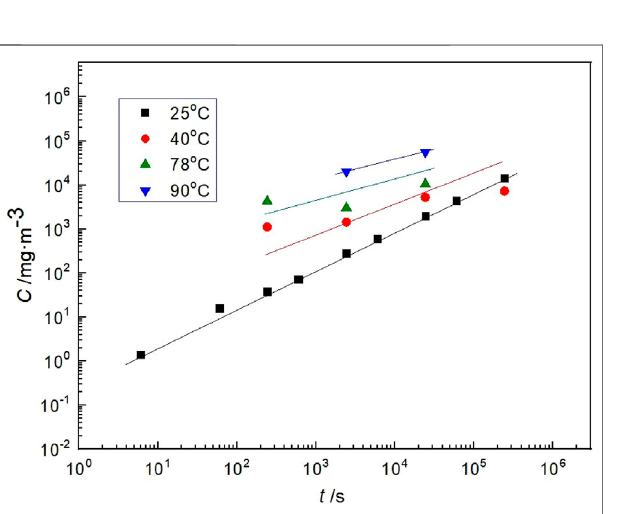
FIGURE 7 | Hydrogen concentration in Q235 steel with temperature at same charging current density of 10 A m − 2 in saturated highly compacted bentonite.